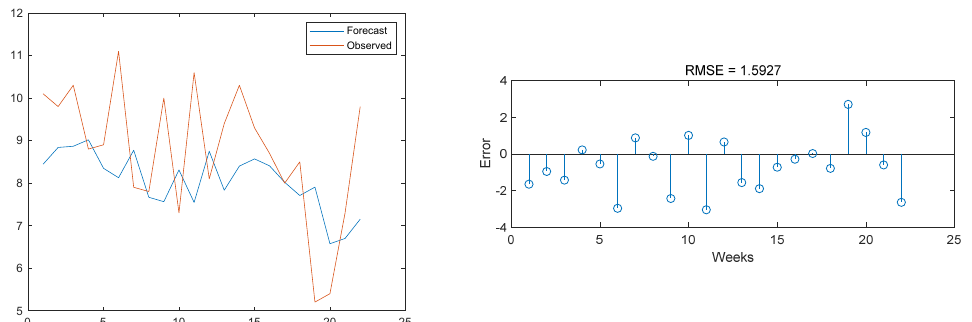
Figure 13. Prediction results of the ANN-LSTM model on the DO test set and comparison with the original image.